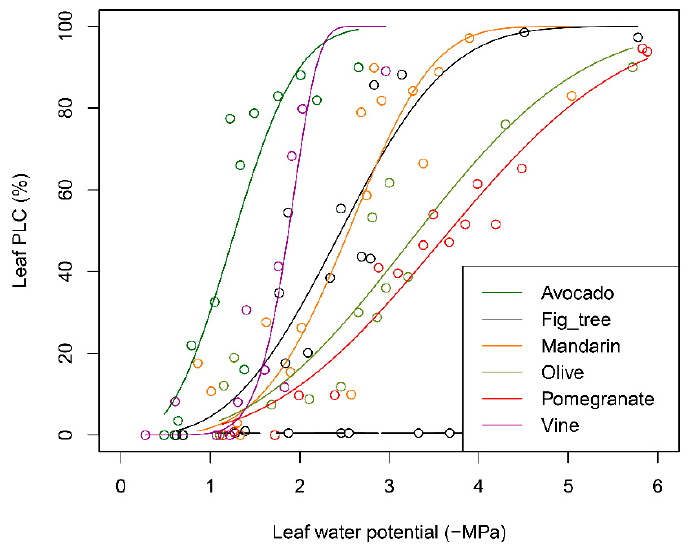
Figure 1. Leaf hydraulic conductance vulnerability curves for six fruit tree species. Black dots and horizontal bars at the bottom of the graph represent the mean and bootstrap 95% confidence interval of P 50 . Table 5. Water potential in which leaf loss was 50% of hydraulic conductance (P 50 ) and slope of the relationship between leaf hydraulic conductance and leaf water potential (S x ) for six fruit tree spe- cies.